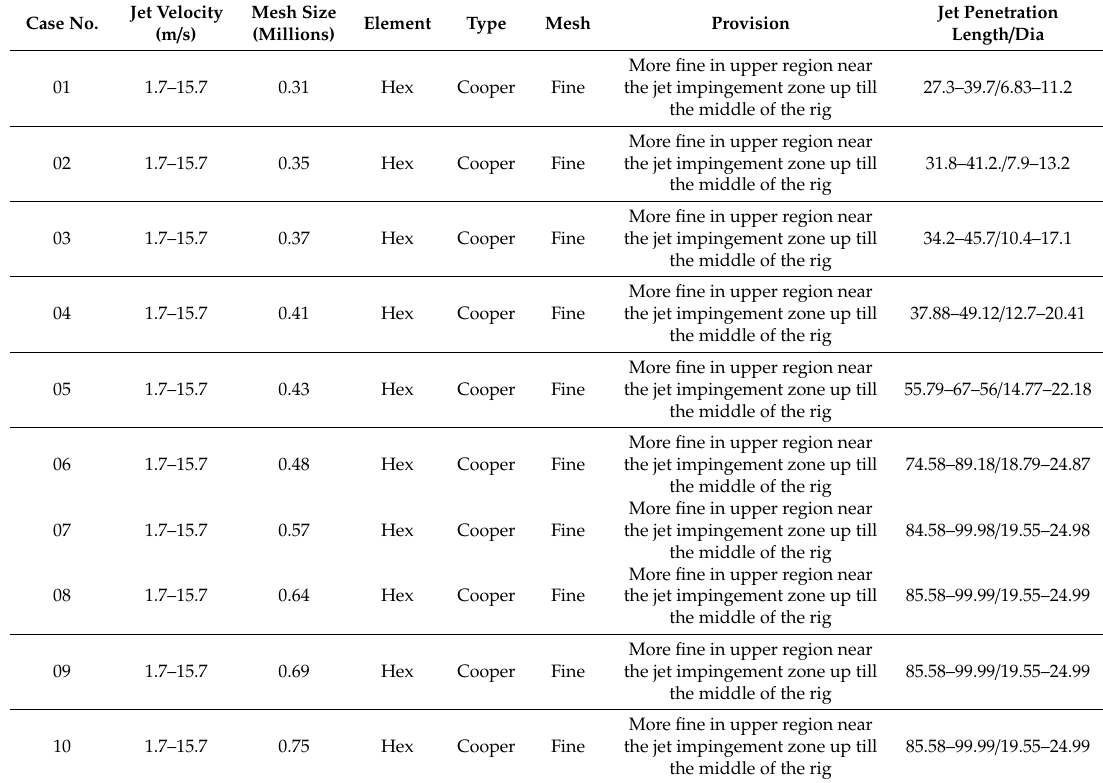
Table 2. Grid Independence